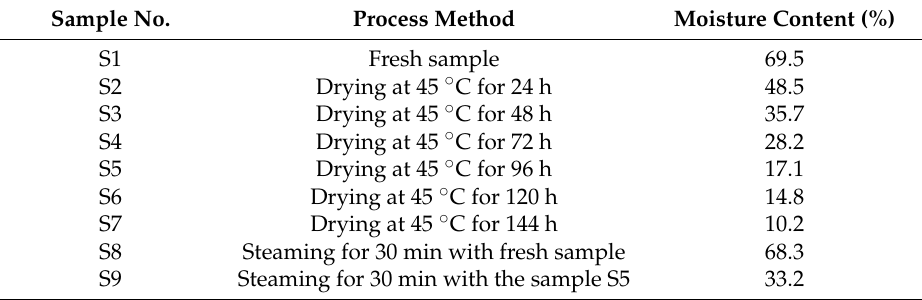
Table 1. The information of the samples preparation and the moisture contents of the samples. Sample